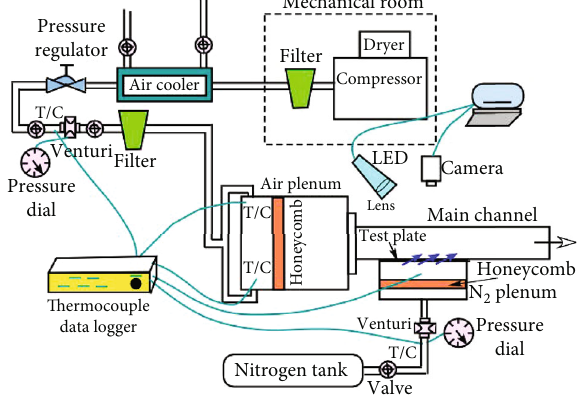
Figure 5: Test rig, associated accessories, and data collection